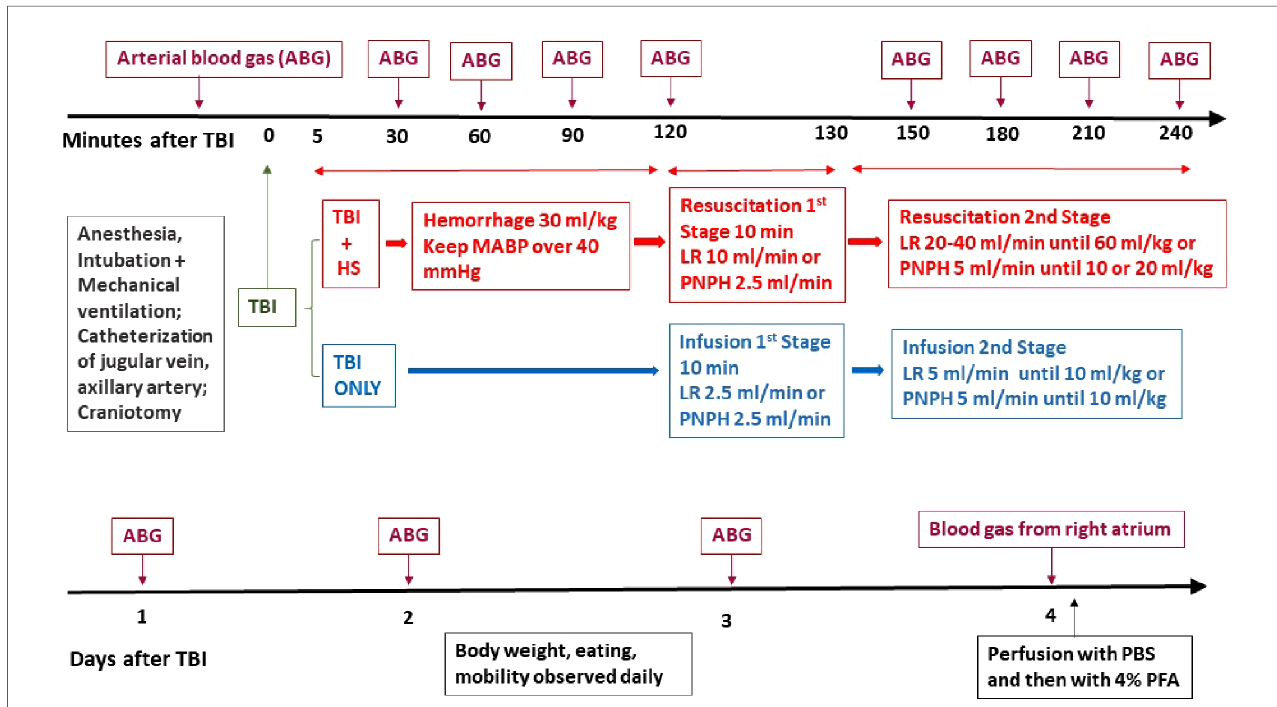
FIGURE 1 Schematic outline of time line of protocol for TBI+hemorrhagic shock (HS) and TBI only experiments on pigs during the fi rst 4 h of recovery (top) and during the 4-day survival period (bottom). ABG, arterial blood gas; CCI, controlled cortical impact; LR, lactated Ringer ’ s solution; PBS, phosphate-buffered saline; PFA,